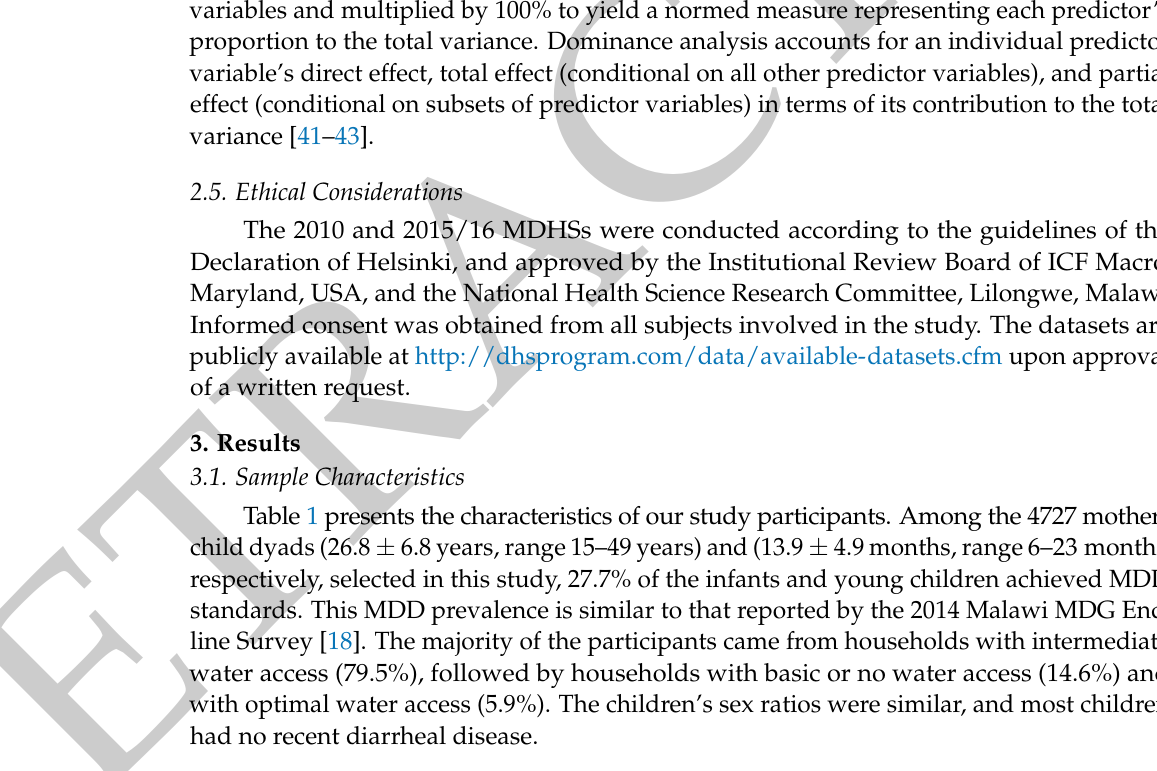
Table 1. Sociodemographic characteristics of the study participants ( n =